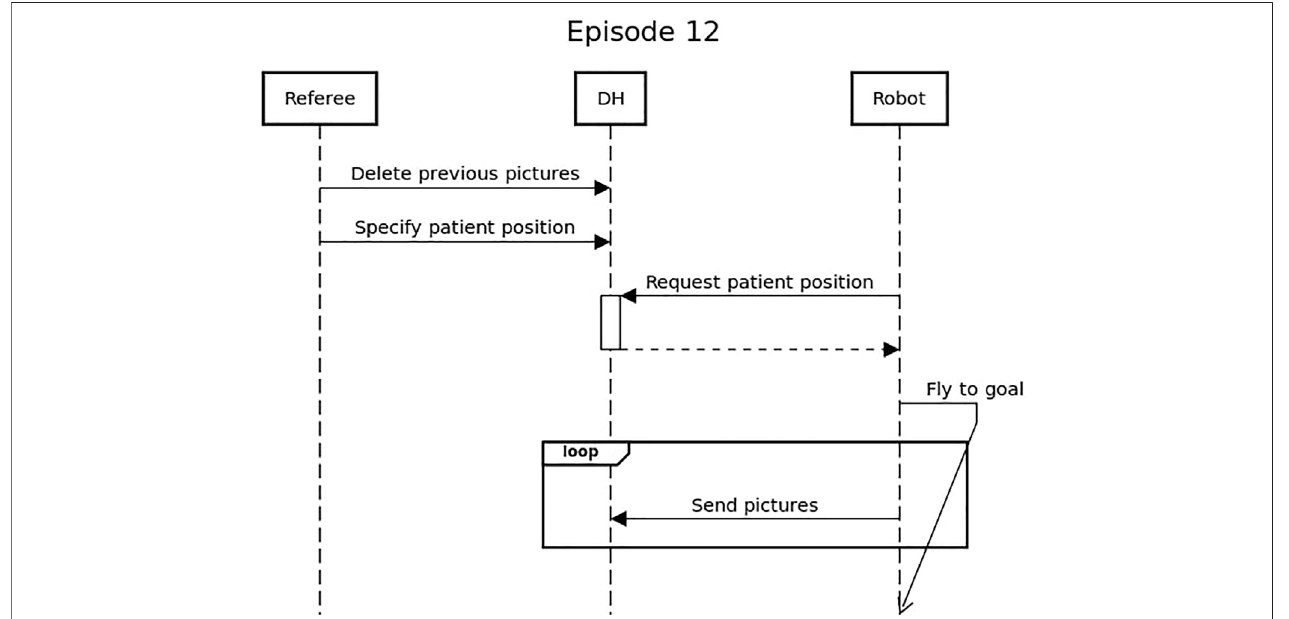
FIGURE 10 | Sequence diagram showing the interaction between the robot and the Data Hub for Episode